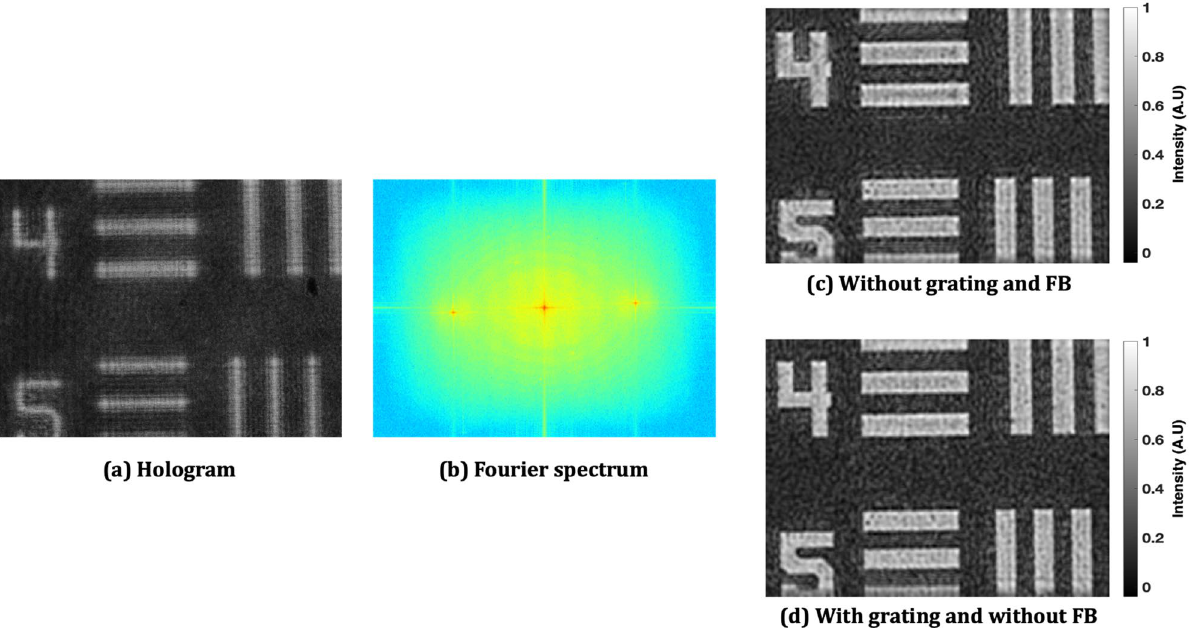
Figure 4. Experimental results of the Mech-Zehnder type DH system: ( a ) recorded digital hologram, ( b ) Fourier spectrum of ( a ); ( c ) the reconstructed image, and ( d ) the reconstructed image when the grating is used just after the